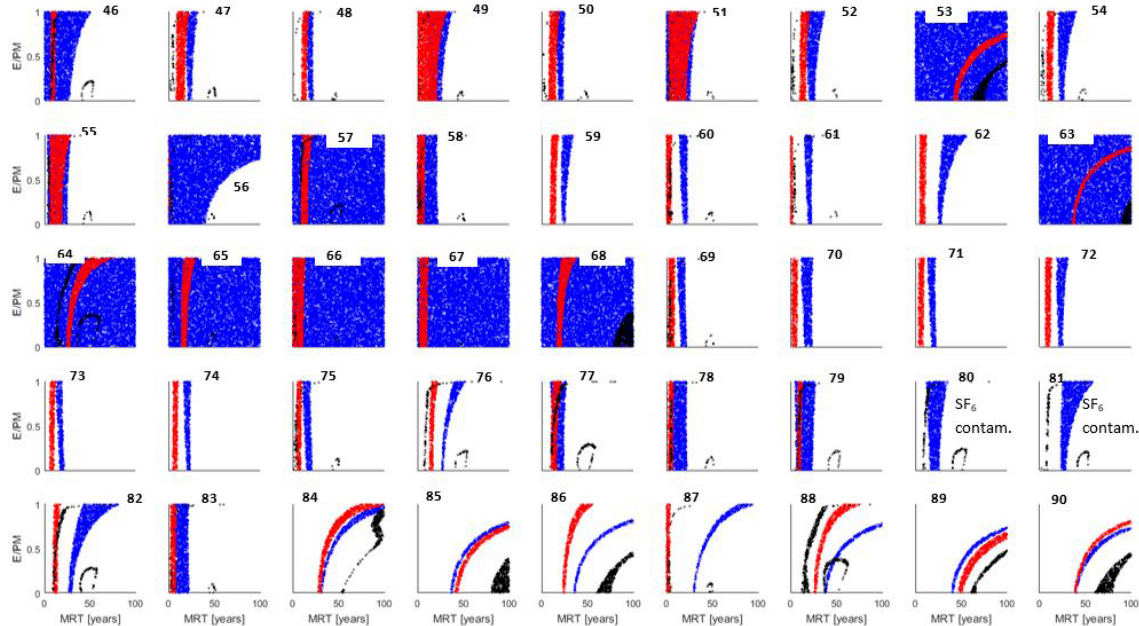
Figure A2. Behavioural age information (MRT and E / PM) inferred from SF 6 (red), tritium (black) and Halon-1301 (blue) for sites 46 to